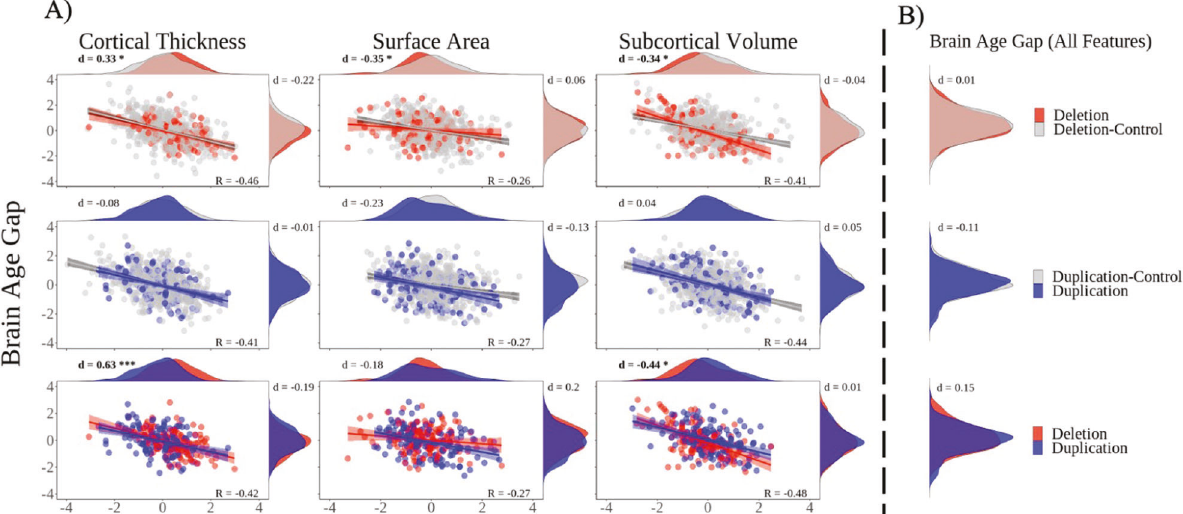
Fig. 1 Brain morphology and brain age in 15q11.2 BP1-BP2 carriers. A Scatterplots: Residualized brain measures vs brain age gap. Density plots; Horizontal: Brain measures, Vertical: Brain age gaps from the ‘ cortical thickness machine learning model ’ , ‘ surface area machine learning model ’ , and ‘ subcortical volume machine learning model ’ . Columns: Mean cortical thickness (left), total surface area (middle), and total subcortical volume (right). Rows: Comparisons between: Deletion carriers versus deletion-controls, duplication carriers versus duplication- controls and deletion carriers versus duplication carriers. B Brain age gap group differences obtained from the ‘ full machine learning model ’ . All values were adjusted for age, age 2 , sex, scanner site, affection status (having either a F or G- ICD10 diagnosis), ICV and Euler number. All values were scaled for visualization purposes. Raw residuals, con fi dence intervals, and p -values can be found in Supplementary Figs. 1 – 3 (for measures of brain morphology) and Supplementary Figs. 6 – 9 (for measures of brain age gap). Red = deletion, carriers, gray = non-carriers, blue = duplication-carriers. R = correlation value across the two included groups. d = Cohens d . Group differences that survive the multiple comparison threshold are marked in bold. * p < 0.0014, *** p <